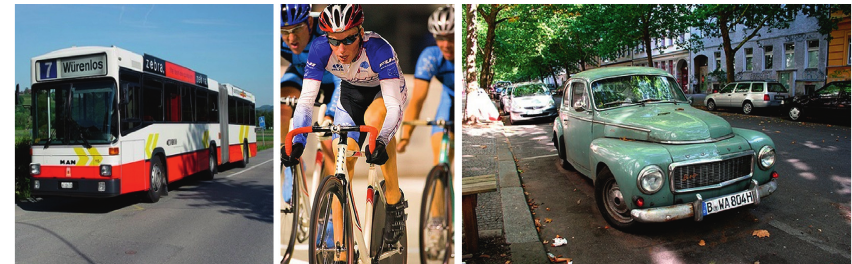
Figure 1: Partial training data set samples.